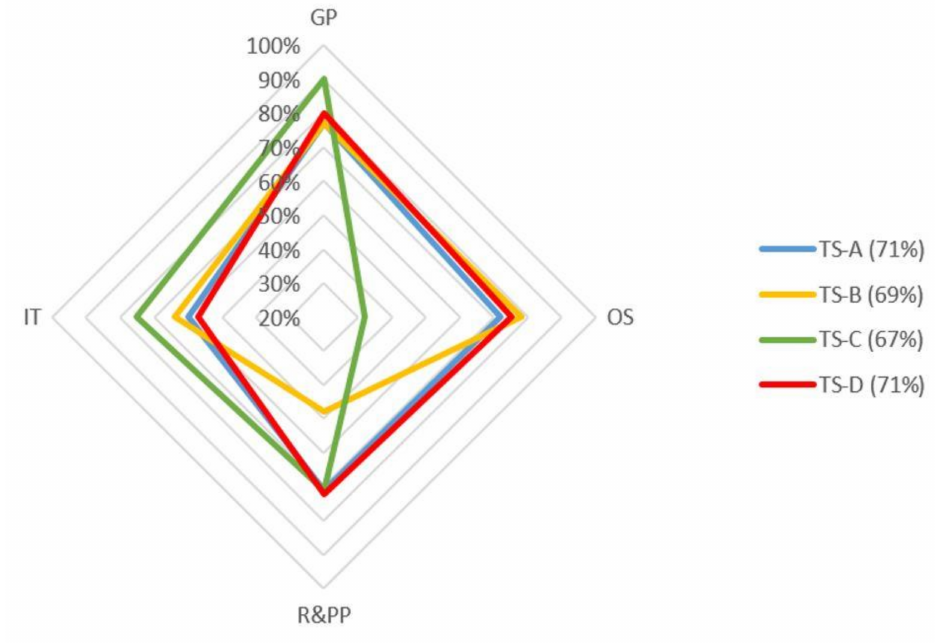
Figure 9. Comparison of Phase-focused Summary Charts from the investigated